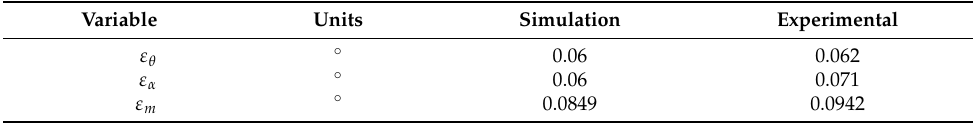
Table 6. Summarized simulation and experimental results of tracking